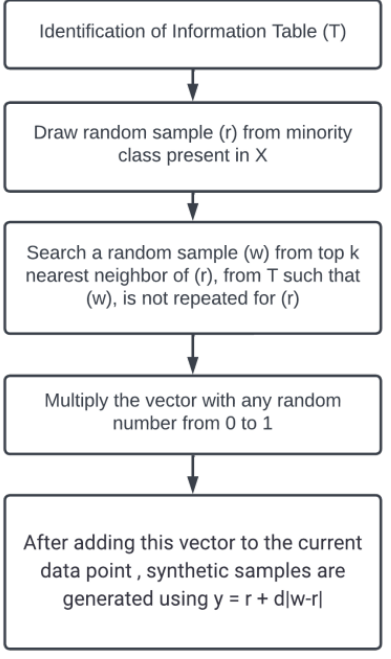
Figure 3. SMOTE algorithm workflow.